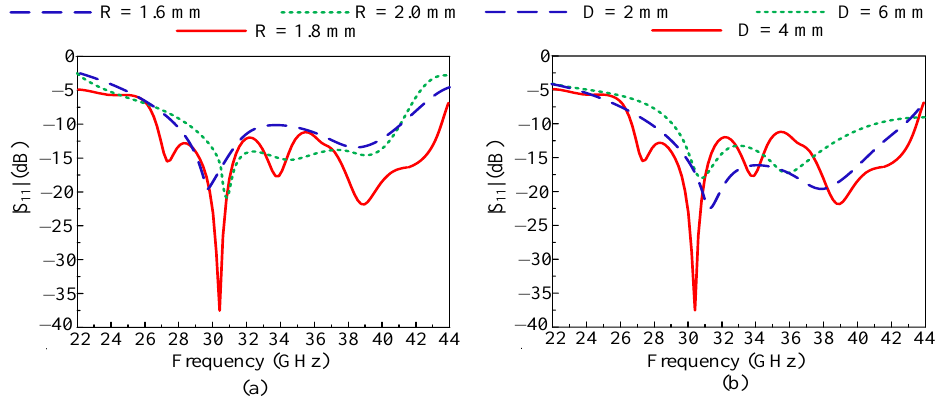
Figure 3. Parametric analysis of ( a ) the radius of the circular patch and ( b ) length of the lower stub.